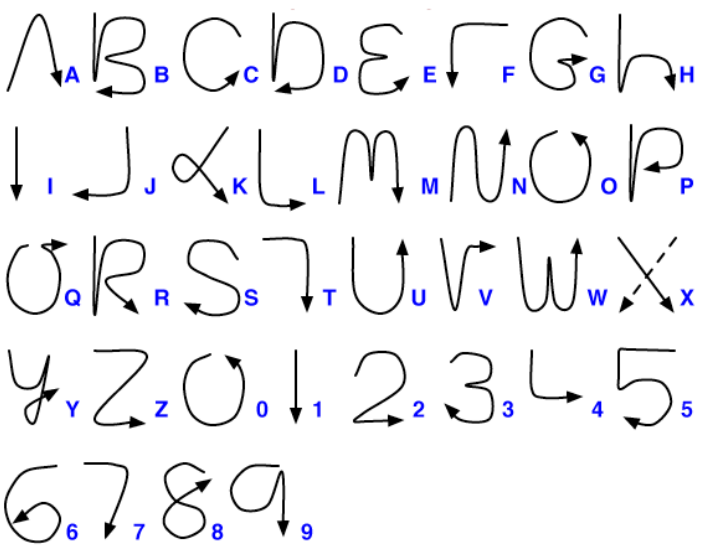
Figure 3. Uni-stroke characters (Graffiti in Palm OS). Reprinted with permission from [17].